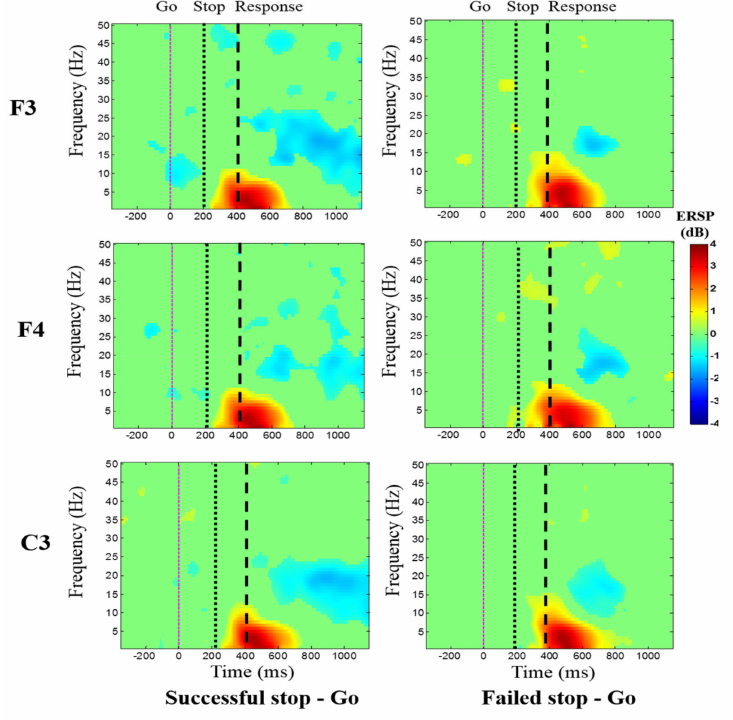
Figure 7. The average ERSP of the EEG signals under “Successful stop—Go” and “Failed stop—Go” conditions at F3, F4, and C3 channels. The first magenta line shows go-stimulus onset. The second black dashed line reveals stop signal onset. The third black dashed line presents response onset. Statistically significant at p < 0.01. Color bars show the scale of